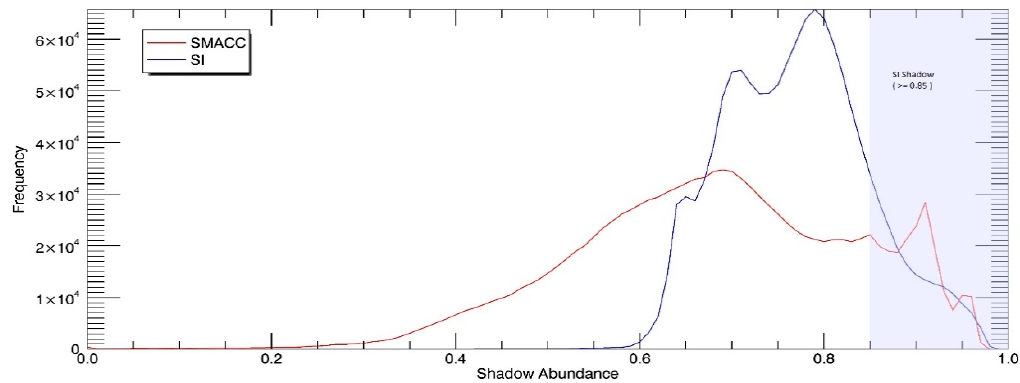
Figure 9. Shadow abundance comparison between SI and SMACC shadow detection methods applied to Worldview-3 imagery. Shaded area indicates SI threshold range ( ≥ 0.85) for shadow.